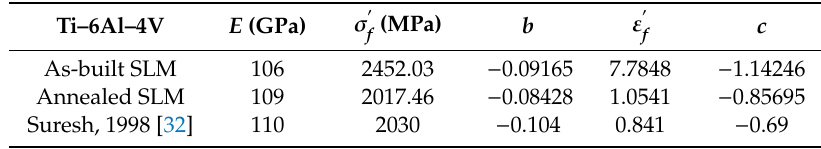
Table 6. Parameters of the Basquin–Co ffi n–Manson model for the selective laser melting (SLM) and wrought Ti–6Al–4V.